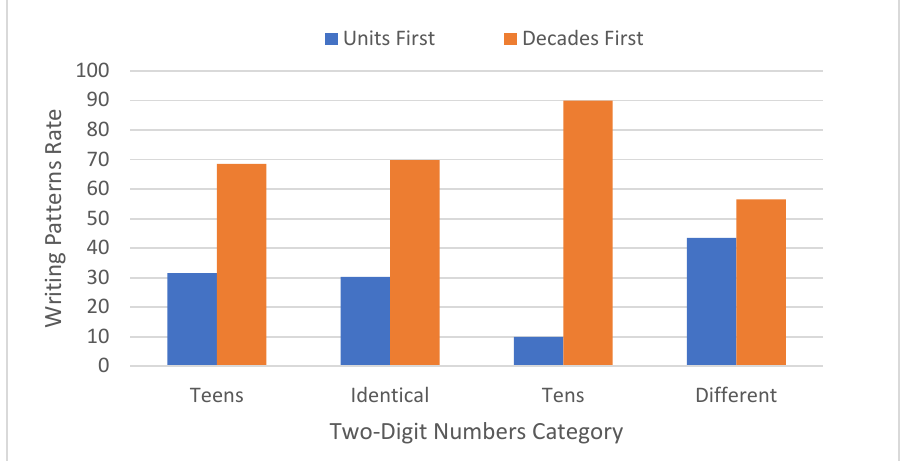
Figure 1. The units-first (right to left) and decades-first (left to right) writing pattern rates as a function of two-digit numbers category (teens, identical, tens and different).